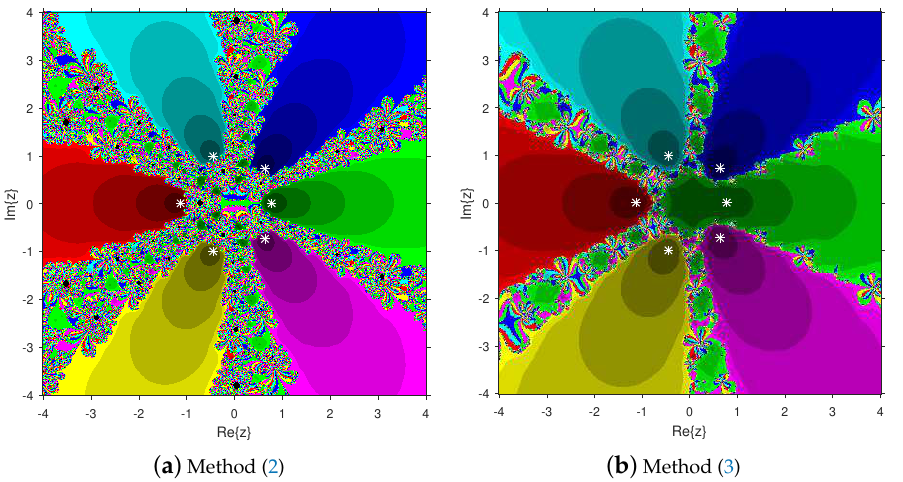
Figure 6. Comparison of attraction basins associated with sixth-degree polynomial O 6 ( z ) = z 6 − z + 1.